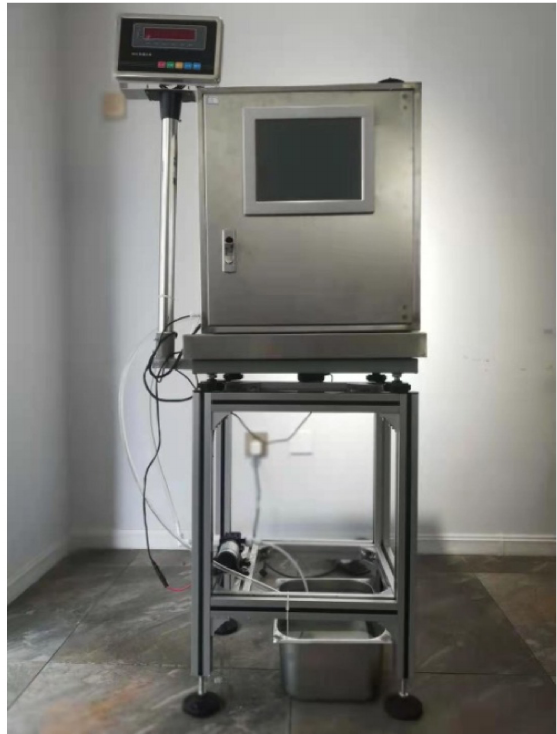
Figure 1. Experimental apparatus photo.